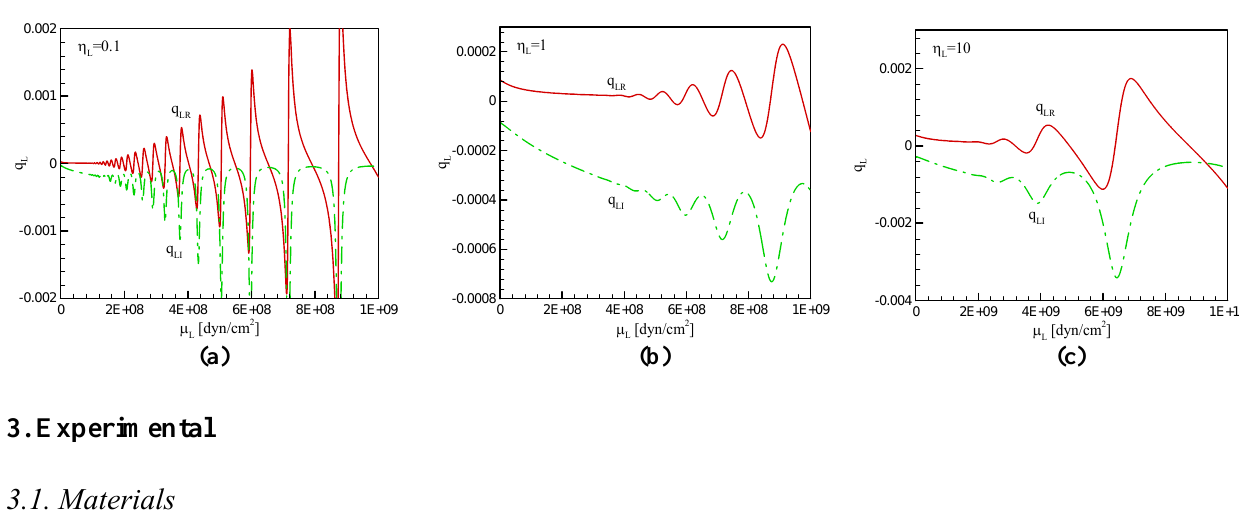
Figure 2. Sketch of a quartz crystal resonator with electrodes on both sides and a viscoelastic overlayer attached on the external surface of an